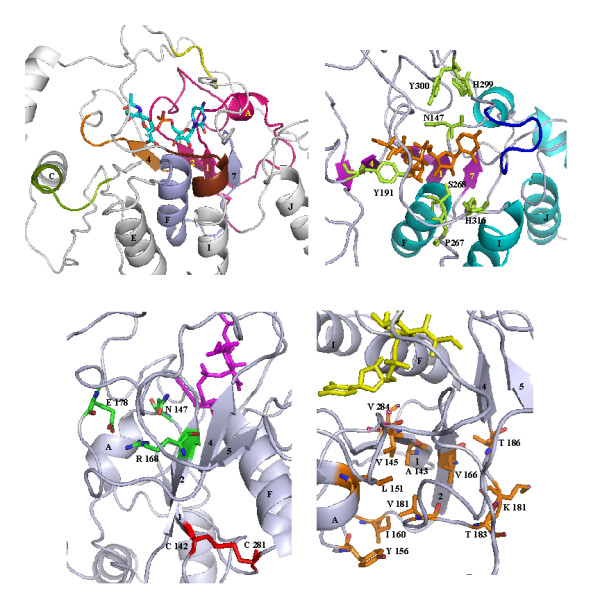
3-D renderings of ST3Gal I model highlighting the various functionally and structurally important residues and regions. The location of the ligand CMP-3-fluoro-NeuNAc as shown in these renderings has been derived by superposition of the modeled structure on that of the CstII- CMP-3-fluoro-NeuNAc complex. (A, top left) 3-D rendering showing the L-motif (magenta), S-motif (purple), VS-motif (burgundy), motif III (yellow), linkage-specific motifs TTx(4)YPE (orange) and FKxxDxxW (green) and (stick diagram). (B, top right) Location of some of the amino acid residues (colored green) whose roles have been investigated by site-directed mutagenesis studies (Table 2). The loop proposed in this study as important for nucleotide binding is shown in blue. The nomenclature used for identifying helices (cyan) and strands (magenta) is as that in Figure 1. (C, bottom left) The interactions of the conserved Arg168 with Asn147 and Glu178. All three residues are buried within the protein. The disulphide bridge (colored red) proposed as required for structural stability has also been displayed. The ligand is in pink. (D, bottom right) 3-D rendering showing the cluster of apolar residues proposed as important for maintaining the 3-D structure (Table 2). Note that not all these residues are in direct contact with the ligand.